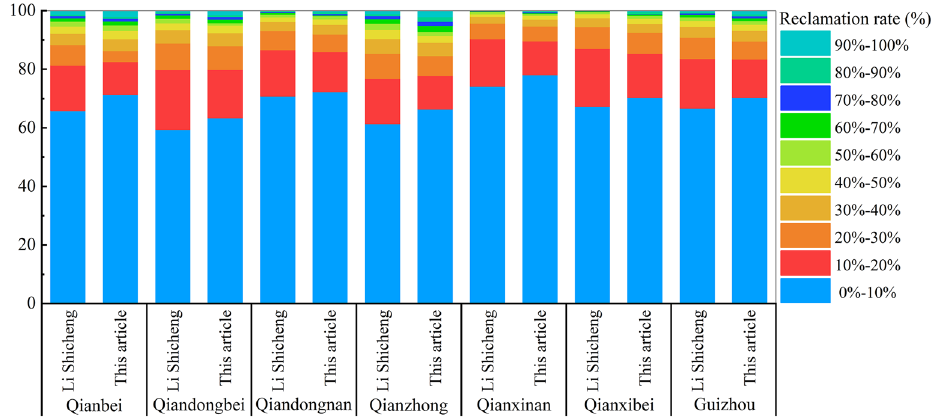
Figure 9. Distribution of reclamation rate intervals by district.